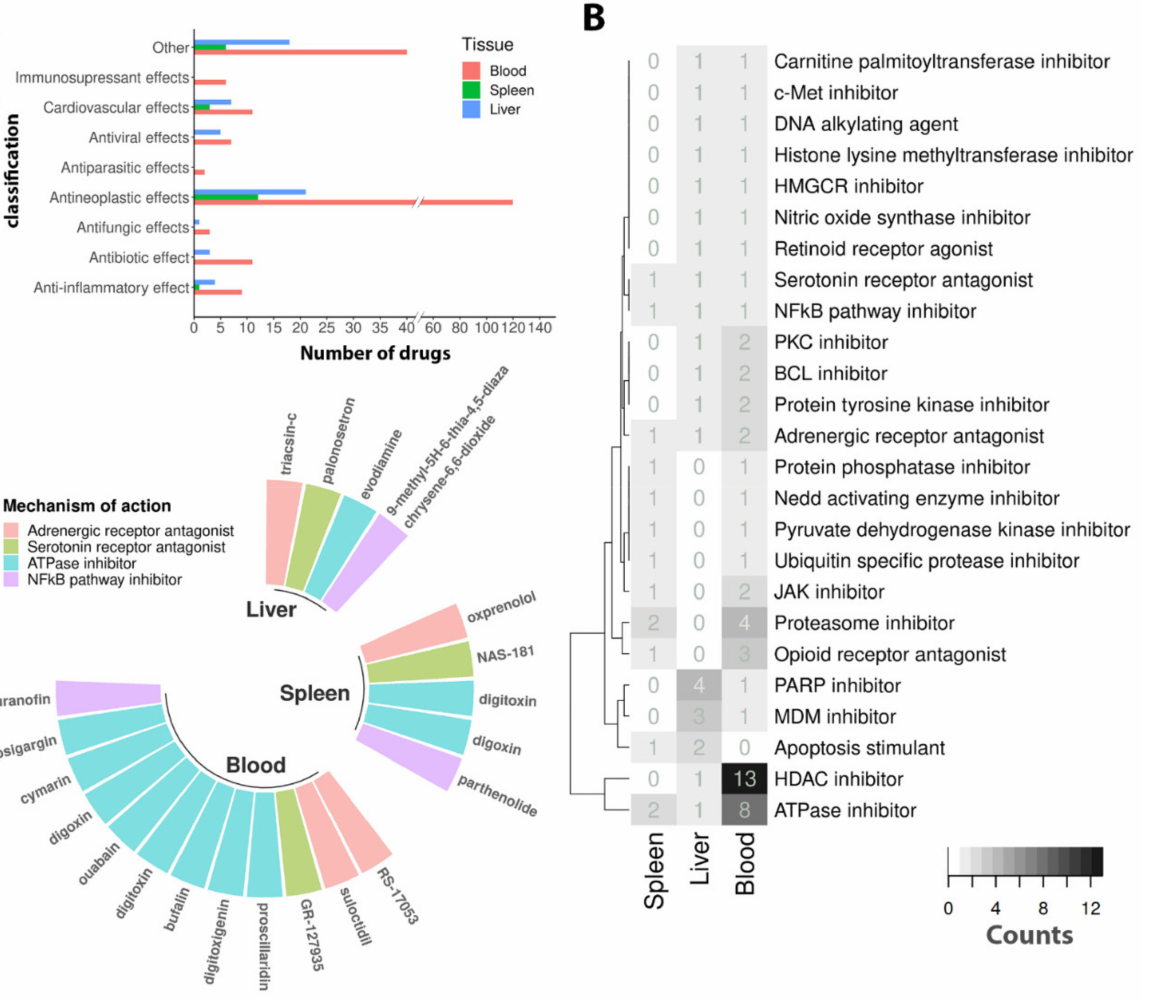
Figure 3. CMap-identified compounds (score equal to or below − 90) that potentially impact Dengue haemorrhagic fever treatment, according to their mechanism of action in the blood, spleen and liver. ( A ) Bar plot of the distribution of drugs by broad pharmacological classification; ( B ) heatmap of drugs per mechanism identified in one or more tissues; ( C ) circus plot of common mechanisms of